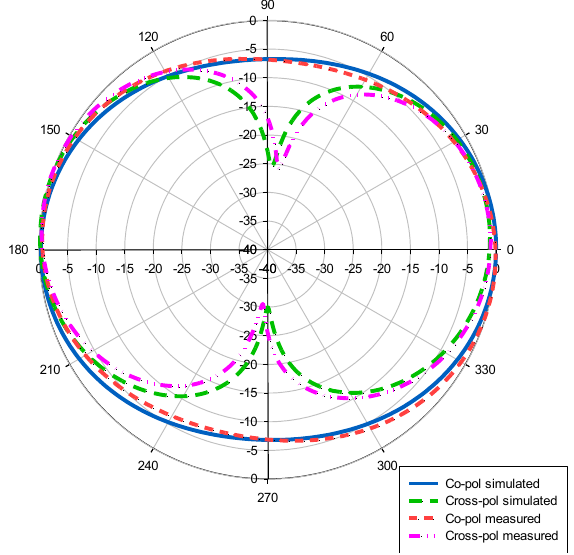
Figure 9: Simulated and measured normalized radiation patterns in the Y-Z plane of the proposed slot antenna loaded with rotated square